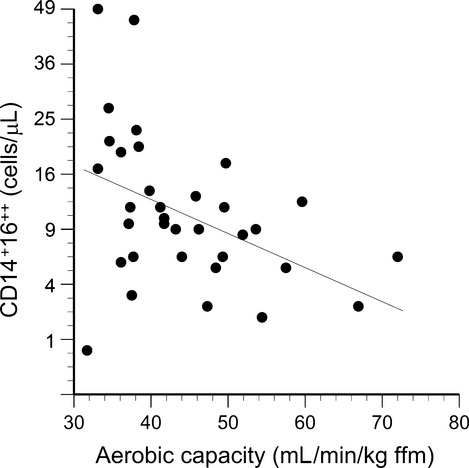
Circulating CD14+16++ cells plotted as a function of the cell donor's aerobic capacity (R = −0.41, P = 0.02).